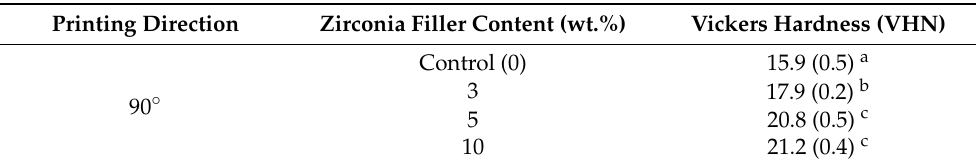
Table 4. Mean (VHN) and SD values of the Vickers hardness for the test groups in the 90° printing direction.